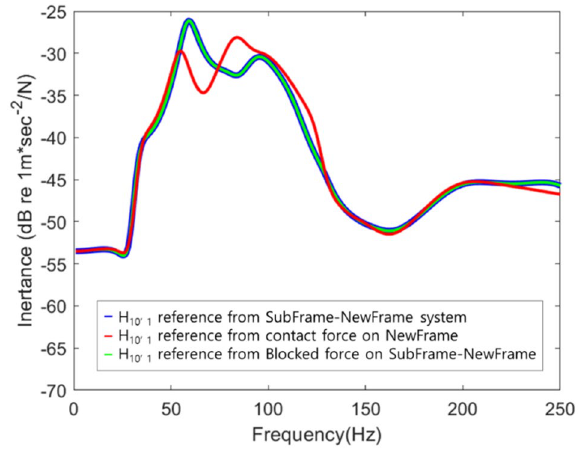
Figure 12. Prediction of responses according to frame changes using contact force and blocked